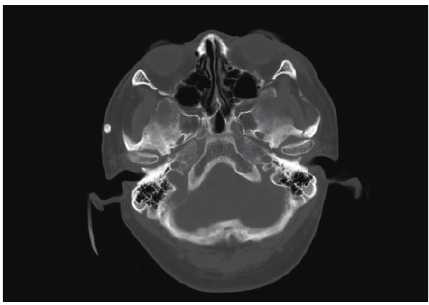
Figure 2: A bone-like hard mass about 10mm in size was palpable subcutaneously at the right preauricular area.